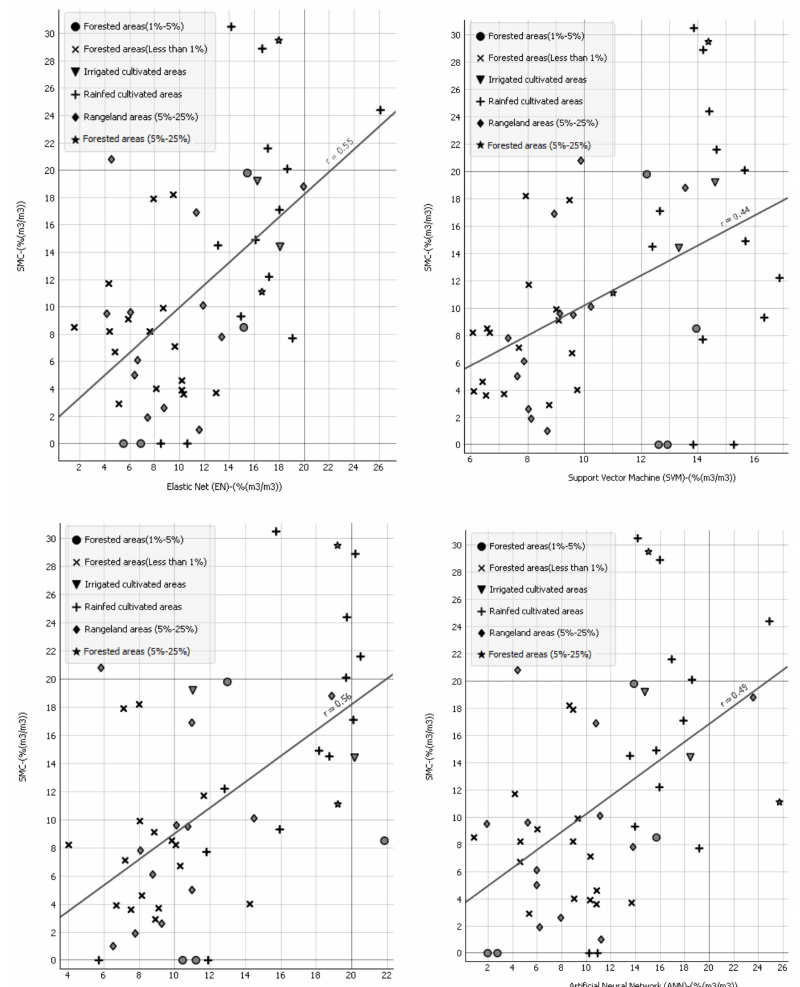
Figure 7. Scatter plots of SMC variable derived for 7 March 2017 from Landsat 8 and land-use data versus observed SMC variable calculated from field measurements extracted for six dominant land-use types in the study